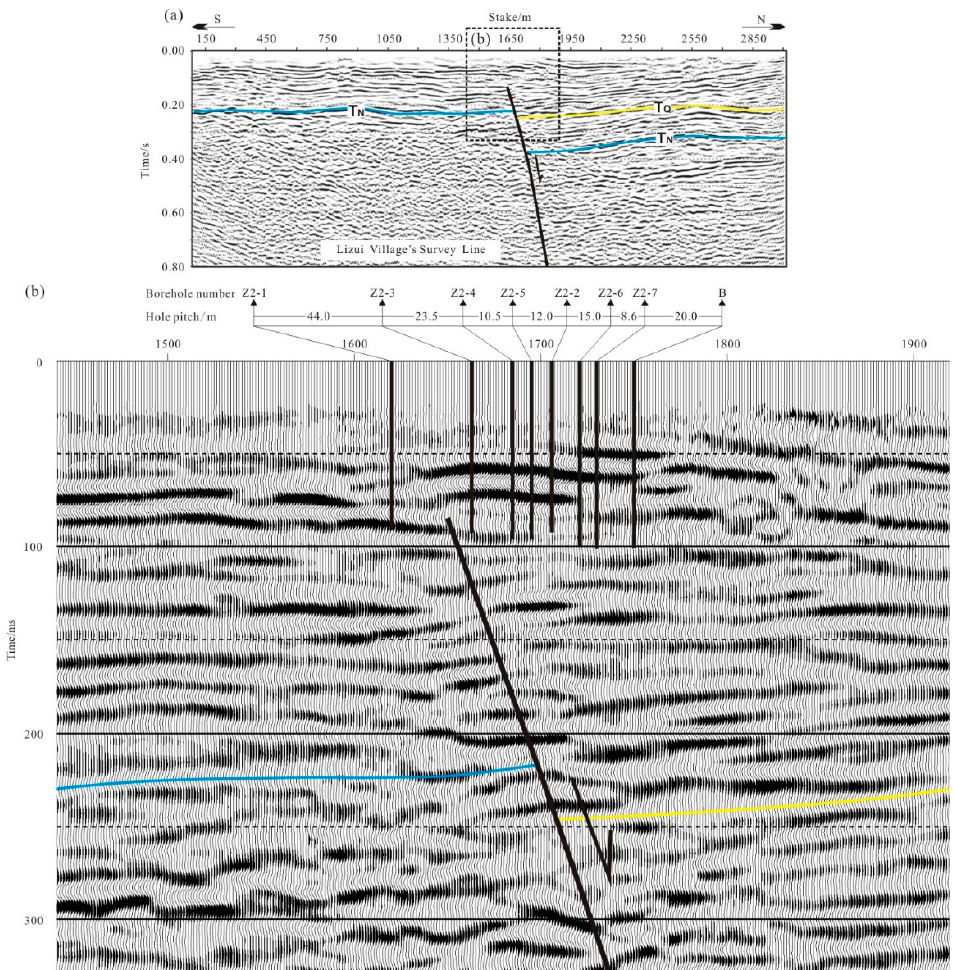
Figure 5. The time profile of Lizui Village’s survey line and the layout of boreholes on composite drilling section in Lizui Village. ( a ) A time-stacked section of the shallow seismic line in Lizui Village. Dashed black box shows the location of ( b ). ( b ) The layout of boreholes on composite drilling section in Lizui Village.